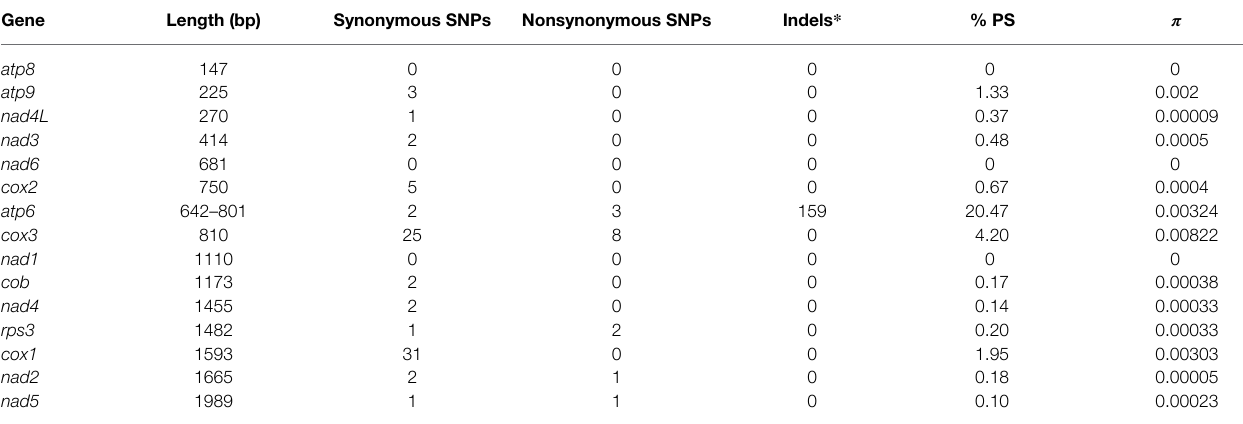
TABLE 2 | Variation in mitochondrial CDS among fungal strains.